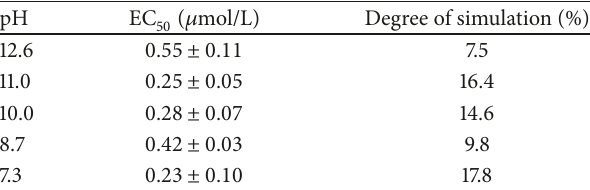
Table 3: EC 50 of FK-Gly at different pH